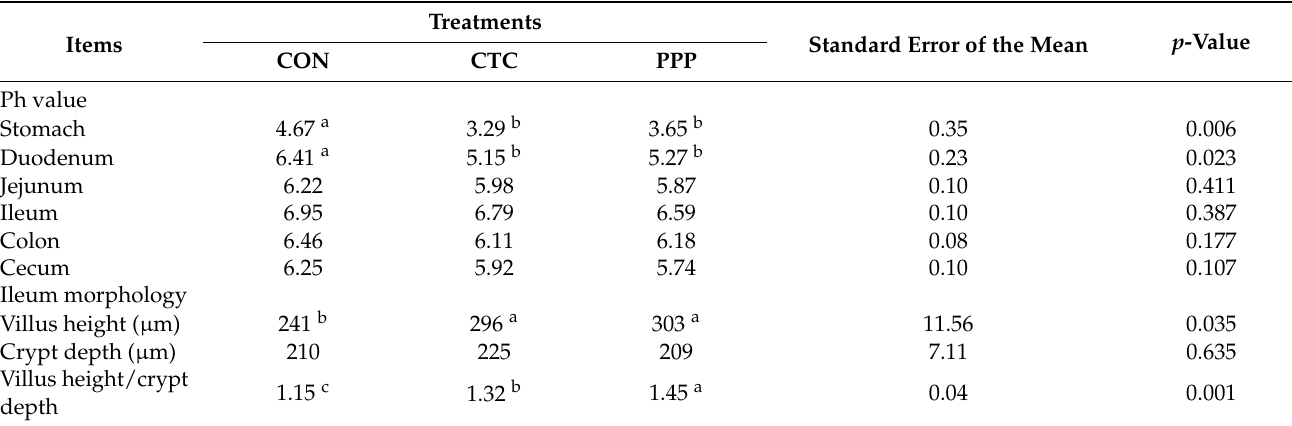
Table 4. Dietary pomelo peel powder affected pH in gastrointestinal tract and ileum morphology of weaned